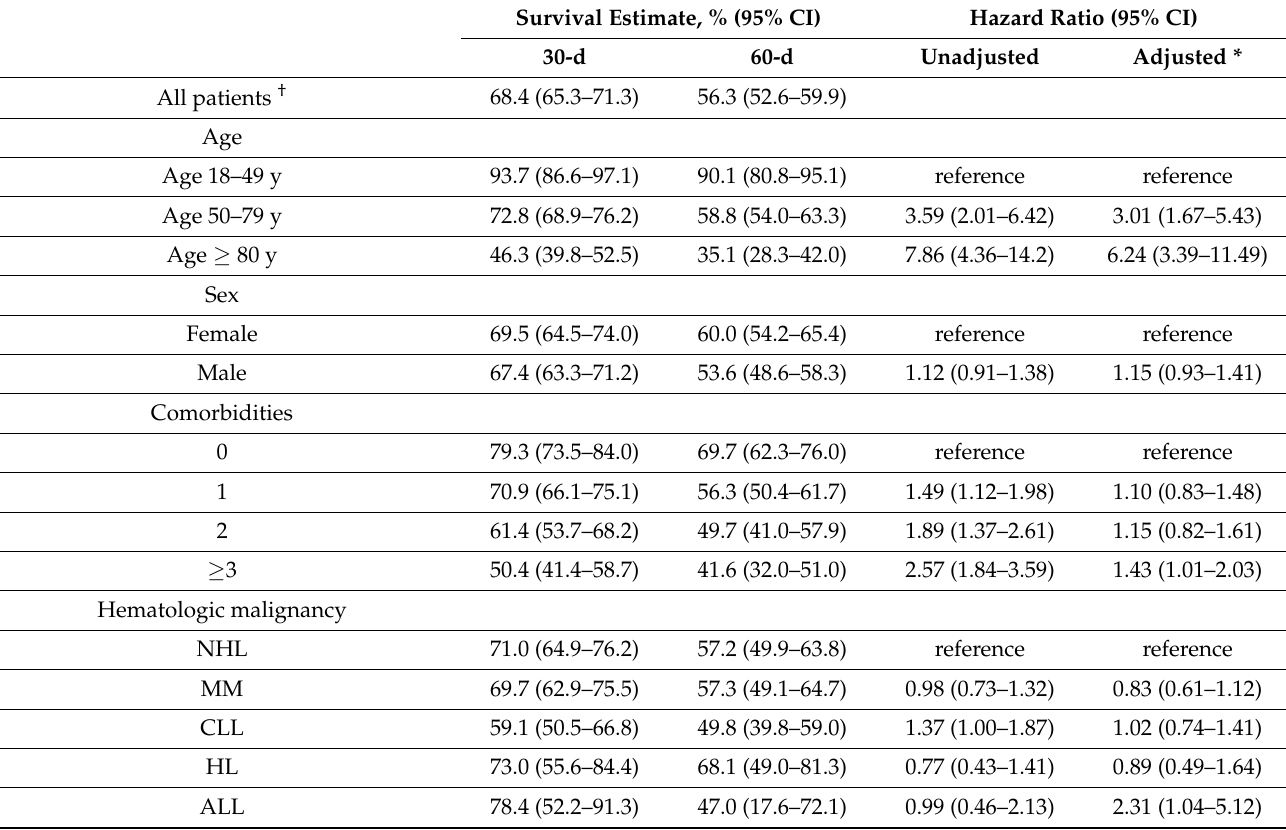
Table 2. Kaplan–Meier estimates of 30-day and 60-day survival in patients with hematologic malig- nancies and